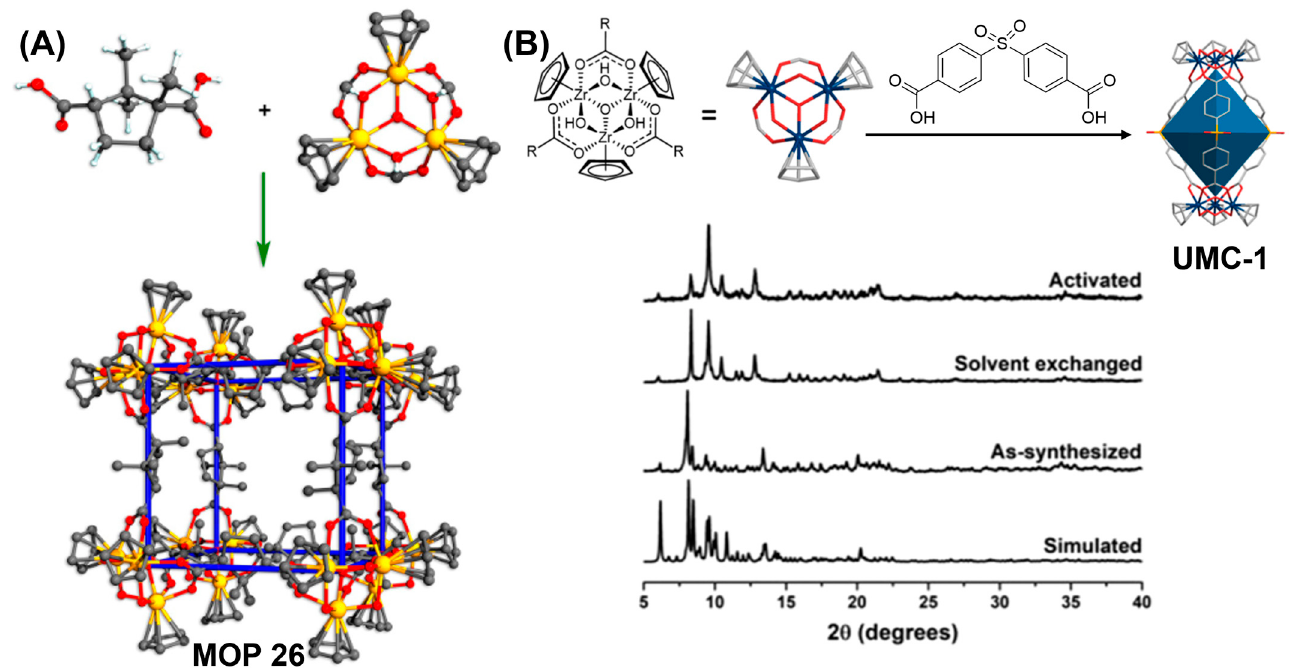
Figure 12. ( A ) Self-assembly of cubic cage [Cp 3 Zr 3 µ 3 -O( µ 2 -OH) 3 ] 8 (D-cam) 12 from D-camphoric acid and Cp 3 Zr 3 O(OH) 3 . ( B ) Synthesis of UMC-1. Simulated and experimental powder X-ray diffraction patterns of UMC-1 when activated. Afterward, the crystallinity of UMC-1 was preserved. Reprinted by permission from Refs. [129,131]. Copyright 2017 from Wiley-VCH and copyright 2018 from American Chemical Society.